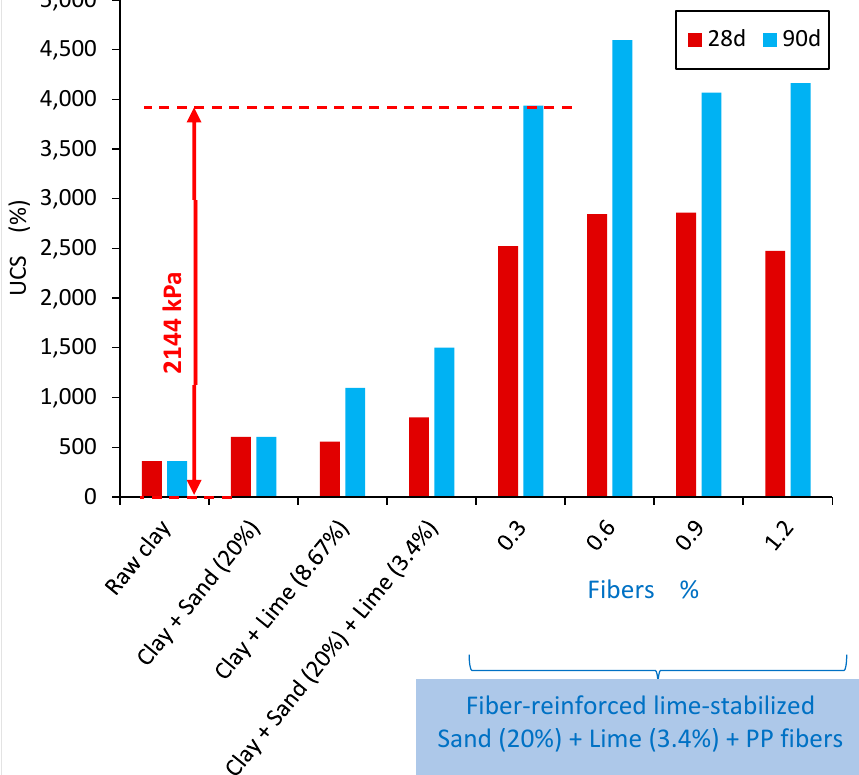
Figure 9. Effect of different additives on UCS.